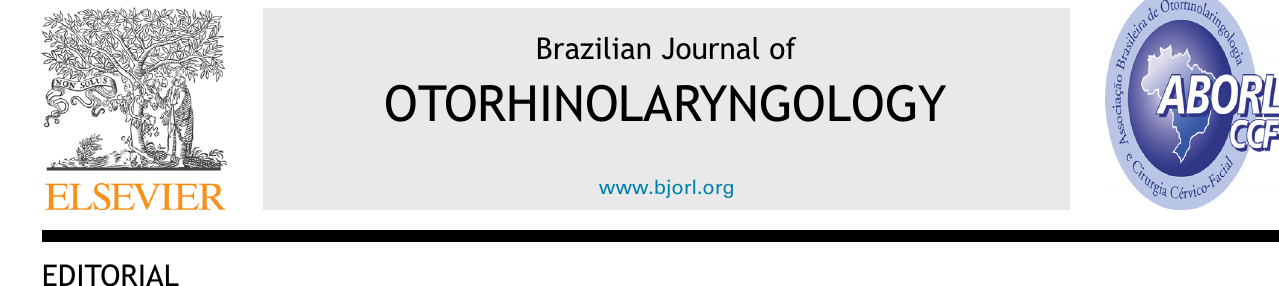
Foniatria: a otorrinolaringologia expandindo os seus